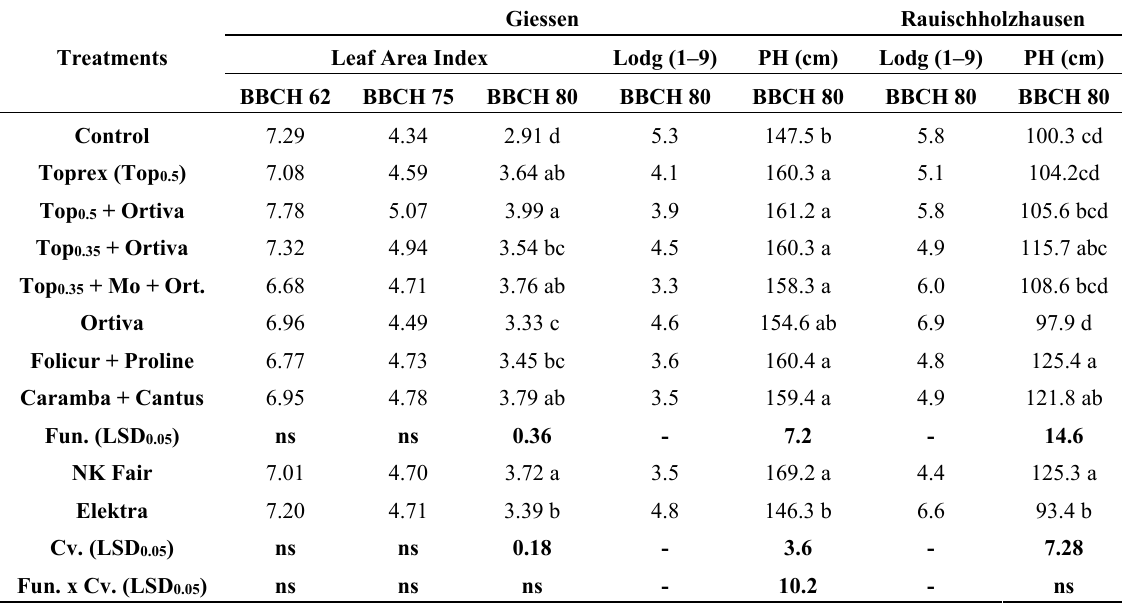
Table 2. Effect of fungicides and growth regulator on leaf area index (LAI) at GI, lodging (Lodg) and plant height (PH) of two cultivars of rapeseed at GI and RH. Giessen Rauischholzhausen Treatments Leaf Area Index Lodg